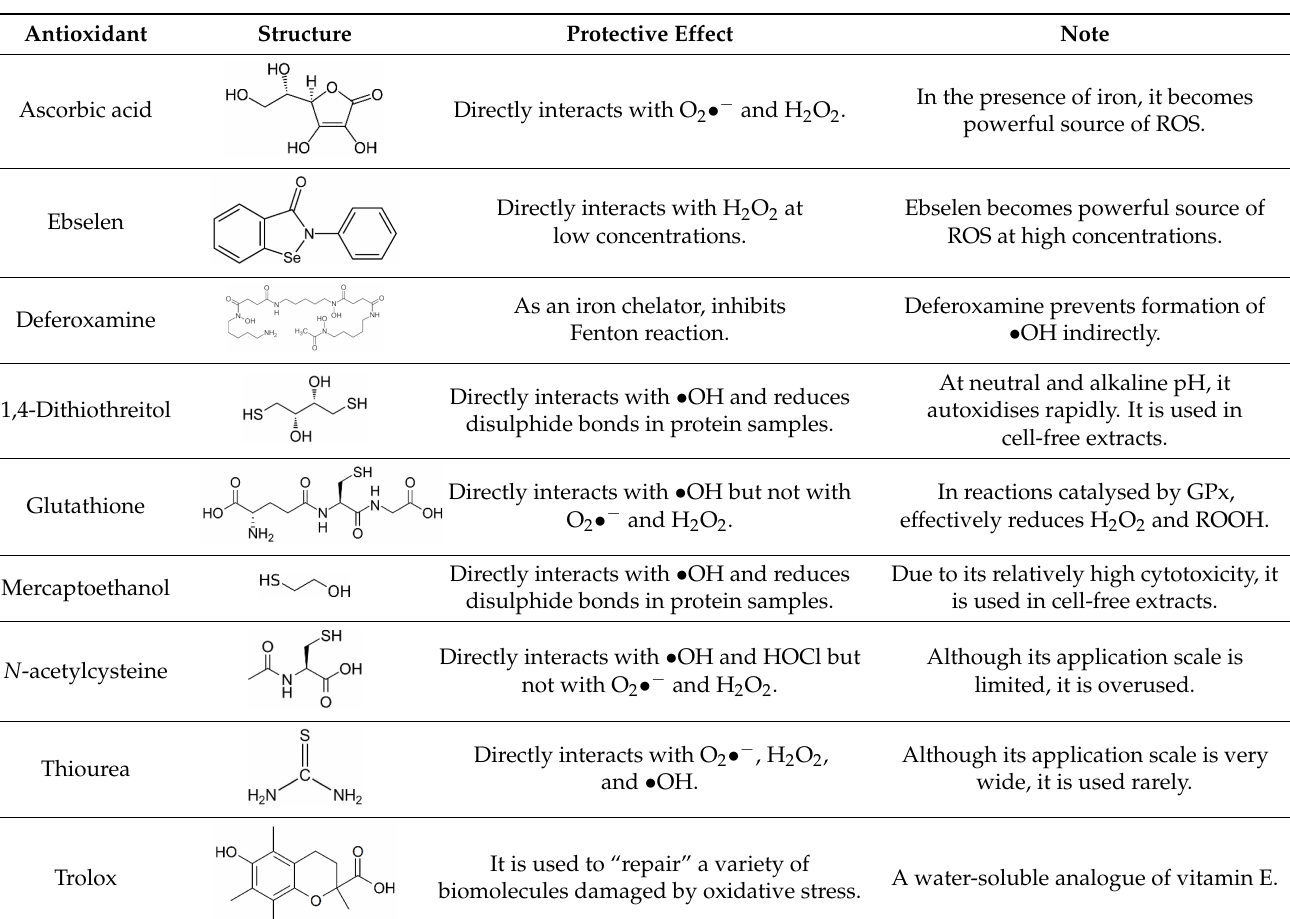
Table 1. Antioxidants frequently used in laboratory